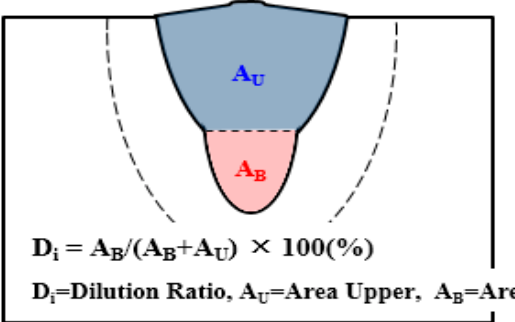
Figure 5. Schematic diagram of dilution ratio.